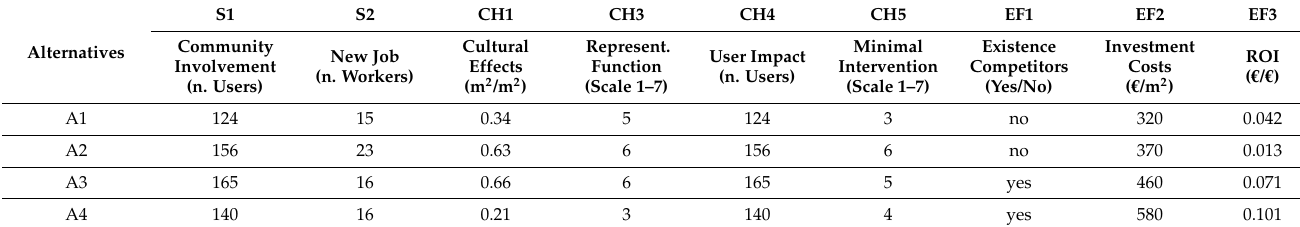
Table 1. The AHP scaled decision matrix.